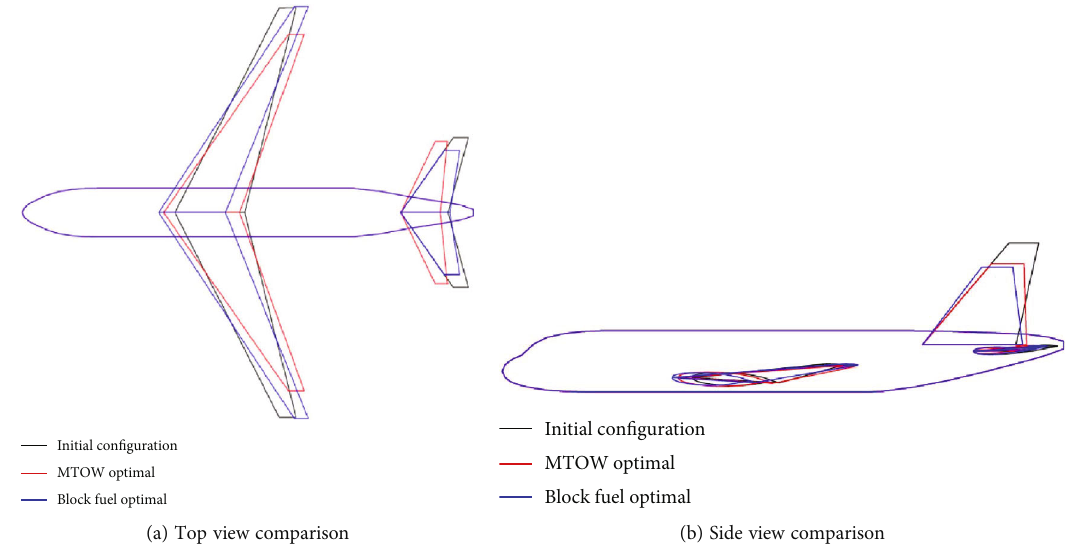
Figure 3: Comparison of HTP, VTP, and wing optimized for minimal block fuel and